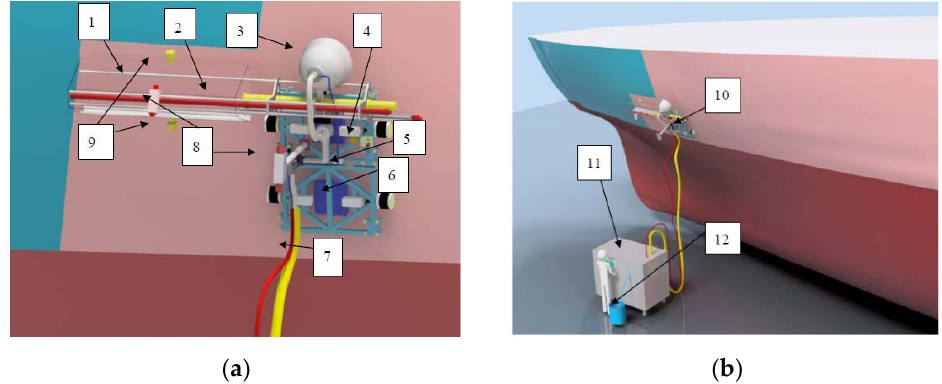
Figure 3. Current status of painting process in Chinese shipyards.